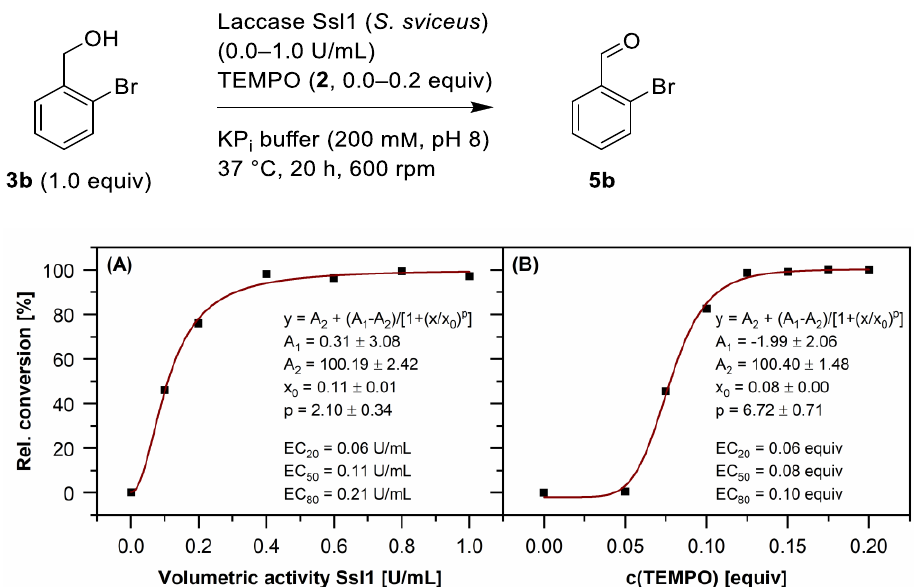
Figure 1. Analysis of the laccase/TEMPO ( 2 ) system for the oxidation of 2-bromobenzyl alcohol ( 3b , c = 0.12 M ) to the corresponding 2-bromobenzaldehyde ( 5b ). ( A ) To determine the conversion for individual volumetric activities of Ssl1 a constant amount of TEMPO ( 2 , 0.175 equiv) was chosen; ( B ) in order to determine the conversion for individual amounts of TEMPO ( 2 ), a constant volumetric activity of Ssl1 of 1 U/mL was chosen. (The rel. conversion is derived from the ratio (benzylic alcohol:benzaldehyde) by GC; the data was analyzed by a logistic regression.).